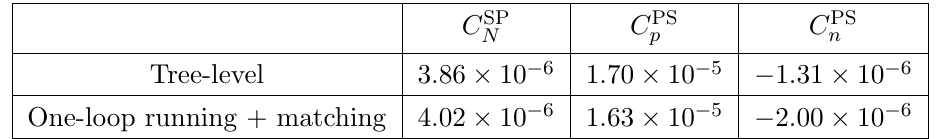
Figure 4 . The relative corrections of the coe(cid:14)cients C SP and matching e(cid:11)ects from the initial scale (cid:3) to the hadronic scale (cid:22) = 1 GeV. Left: assuming only a nonvanishing C g at (cid:3), with N = p; n ; middle and right: assuming only a nonvanishing ~ C g at (cid:3).